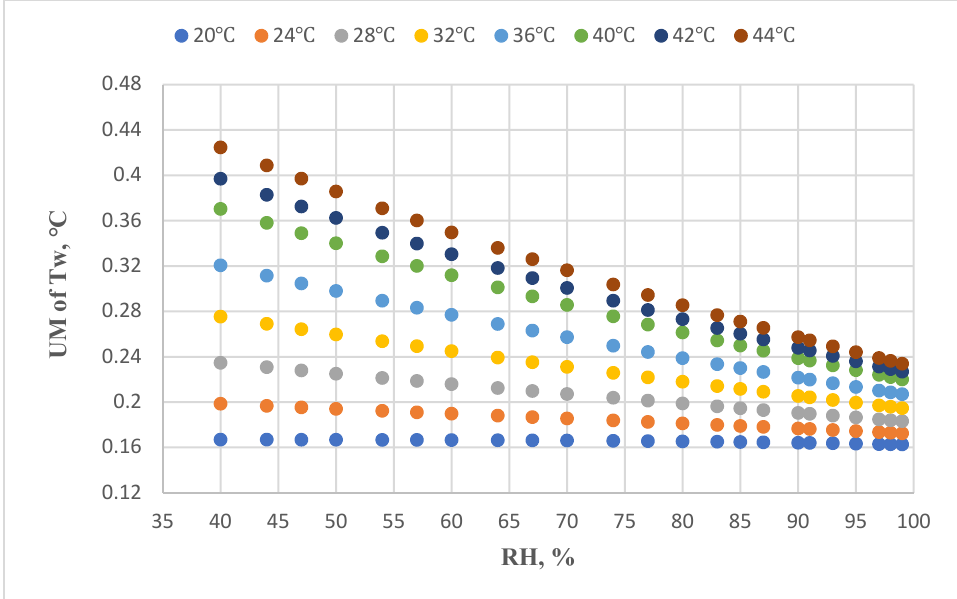
Figure 8. The expanded measurement uncertainty for different Td and RH values if the Td and RH sensors are calibrated.